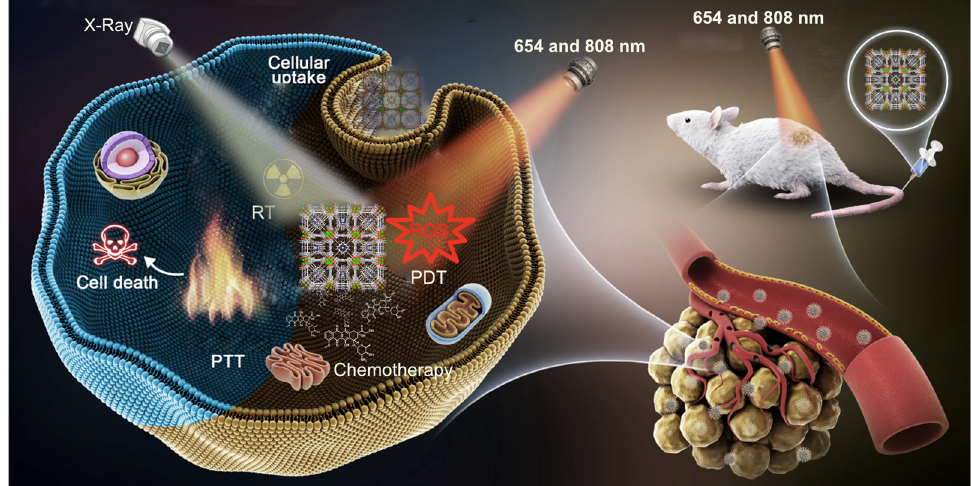
Figure 2. Schematic illustration of cancer therapy techniques used with porphyrin NMOFs. Reprinted/adapted with permission from Ref. [54] .